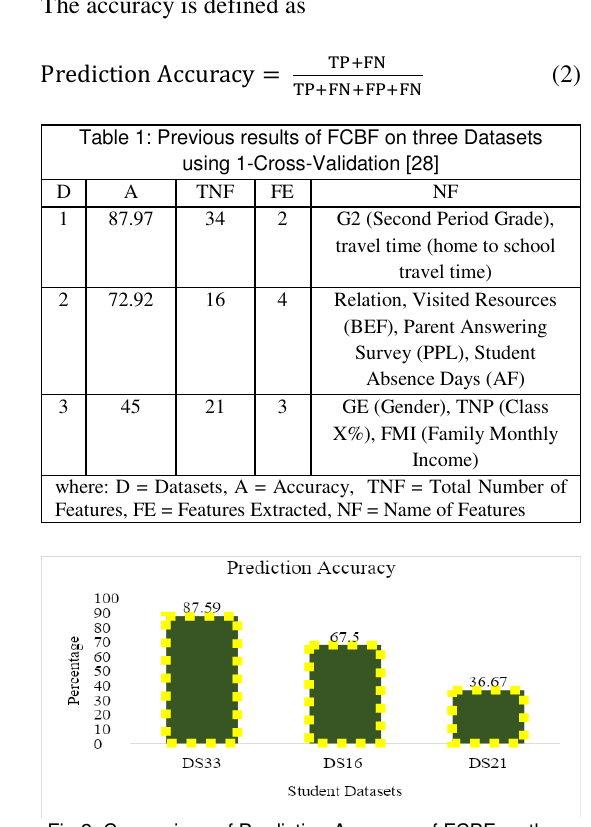
Fig 2: Comparison of Prediction Accuracy of FCBF on three datasets